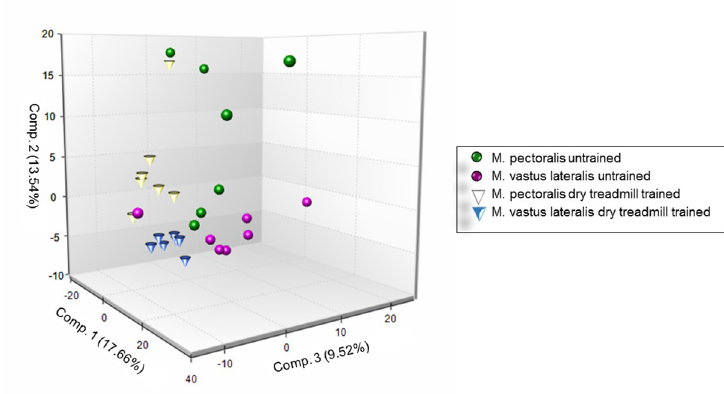
Fig 10. Principal component analysis (PCA) of metabolomic datasets. PCA was performed on the M. pectoralis and the M. vastus lateralis of untrained and dry treadmill trained Friesian horses.